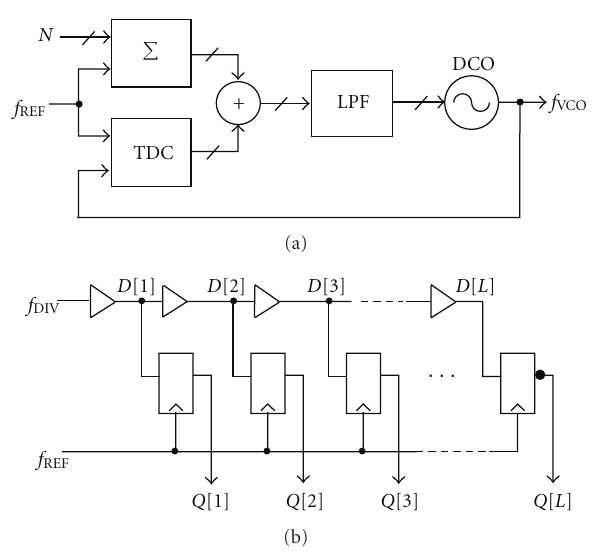
Figure 2: ADPLL with linear TDC [1].